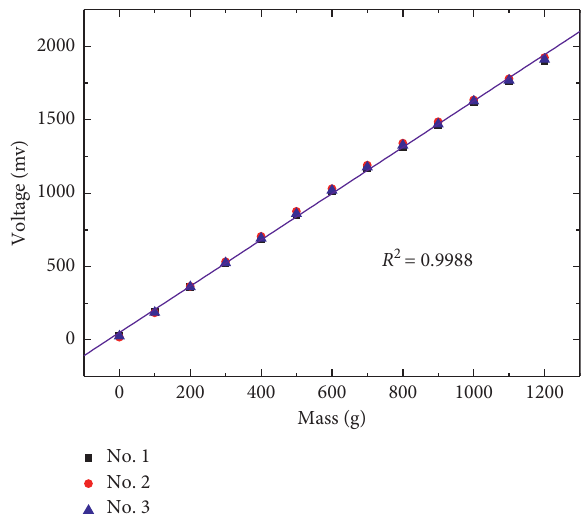
Figure 7: The force-voltage curve of elastic strain in